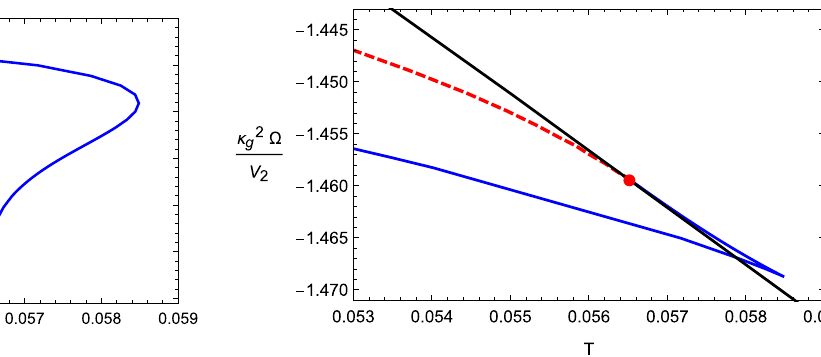
Fig. 1 Then condensate (left plot) and grand potential (right plot) curves for the p-wave and p + ip solutions with m 2 = 0 . 3 and b = 0 . 68. We use solid blue line to denote the curves for p-wave solution and the